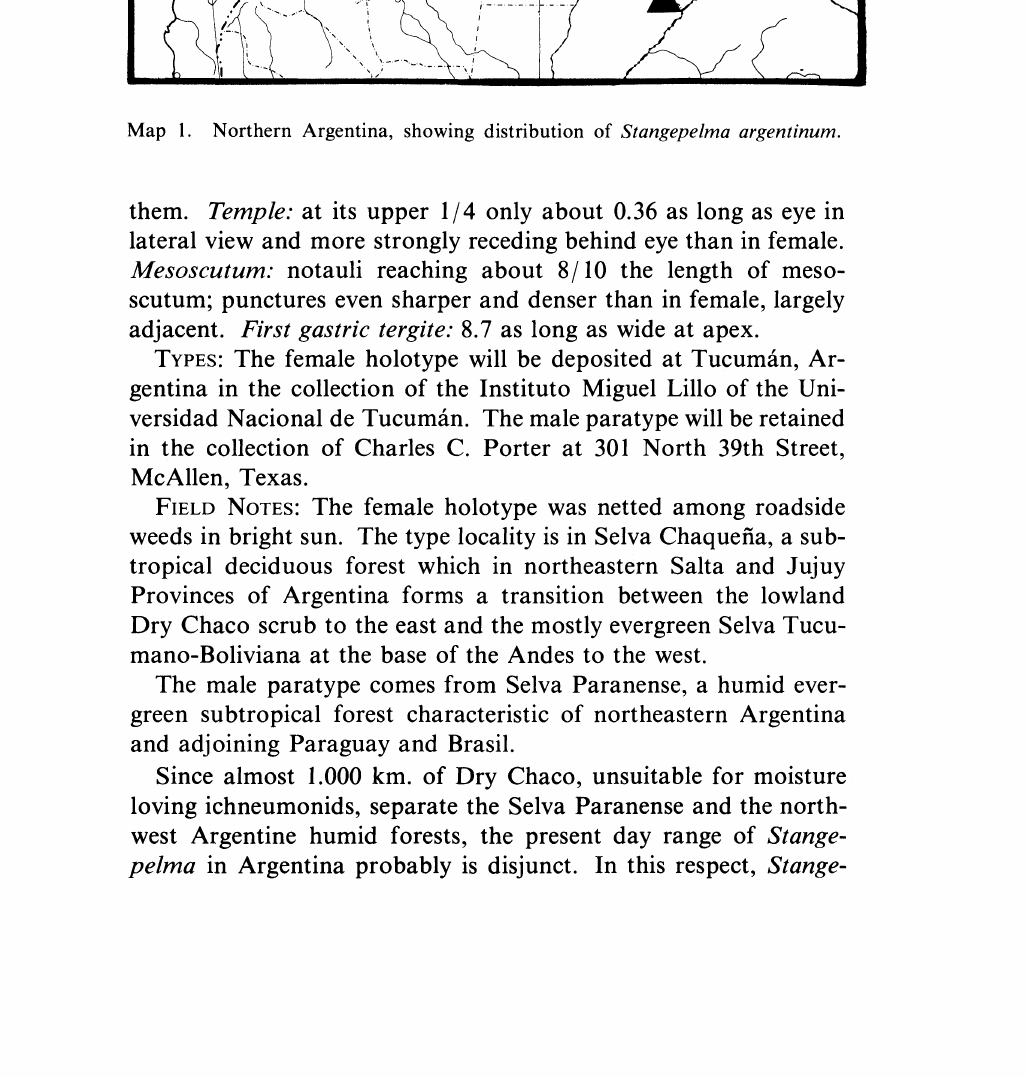
Map 1. Northern Argentina, showing distribution of Stangepelma